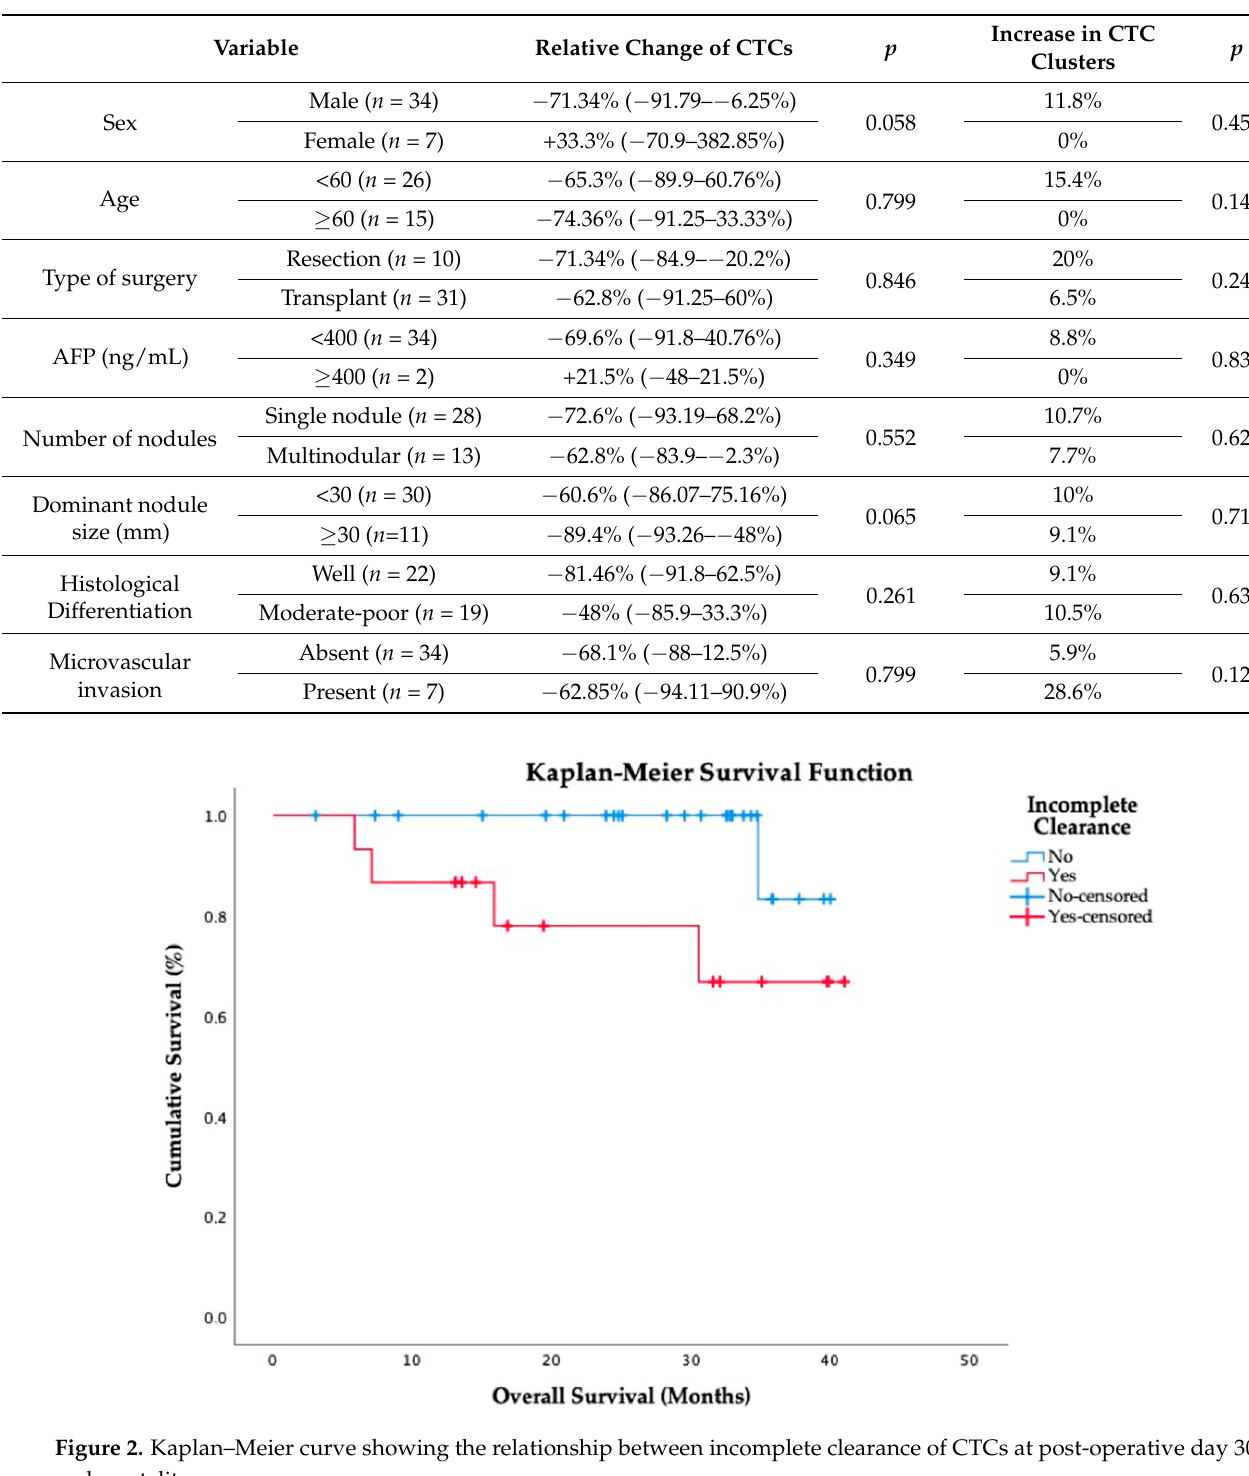
Table 3. Relative delta changes of CTCs enumeration and clusters from baseline to post-operative day 30 according to clinical features.